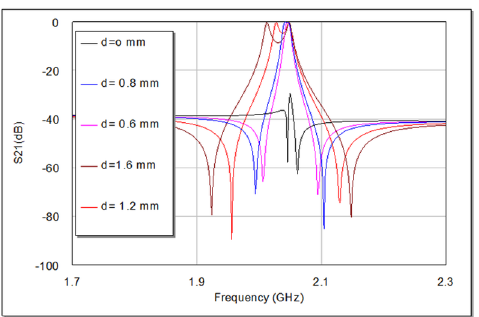
Fig 6. Simulated transmission responses, S21, of proposed BPF as a function of d in units of mm.